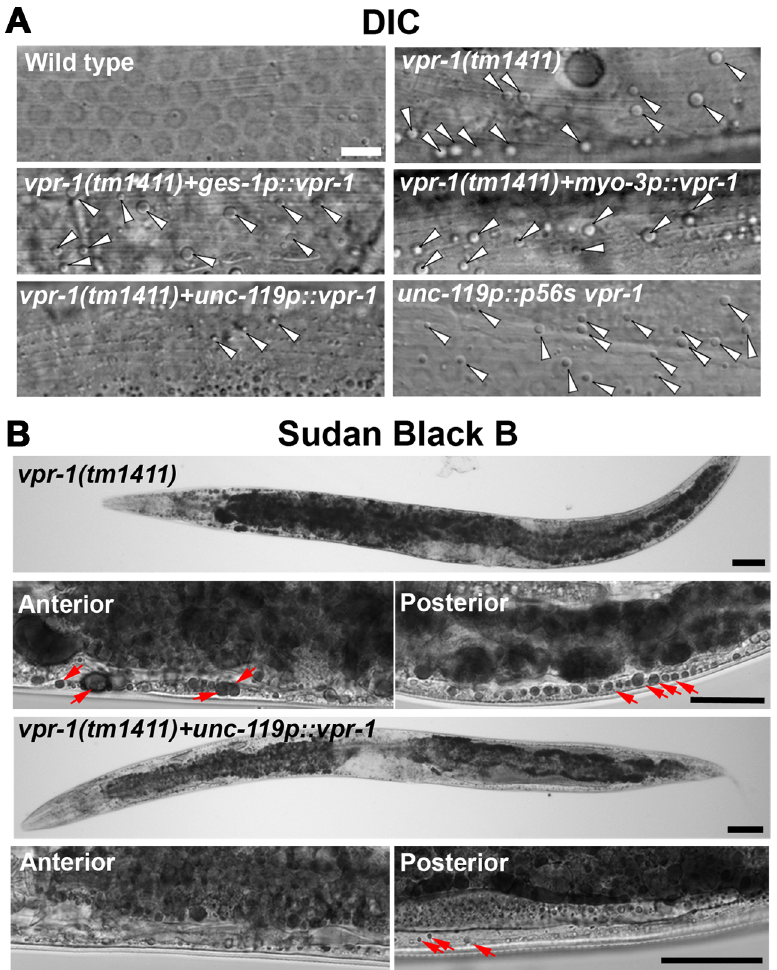
Figure 3. Effect of tissue-specific vpr-1 expression on fat levels. (A) DIC images of muscle in live wild-type and vpr-1(tm1411) mutant hermaphrodites expressing wild-type VPR-1 or VPR-1(P56S) under indicated tissue-specific promoters. Arrowheads indicate lipid-like droplets. Bar, 5 m m. (B) Sudan Black B staining images of vpr-1 mutants expressing vpr-1 under the unc-119 pan-neuronal promoter. Arrows indicate muscle fat droplets. Anterior is to the left in all panels. Wild-type controls (Figure S3) are similar to transgenic vpr-1(tm1411) mutants expressing unc119p::vpr-1 . Low magnification bars, 50 m m; high magnification bars, 25 m m.